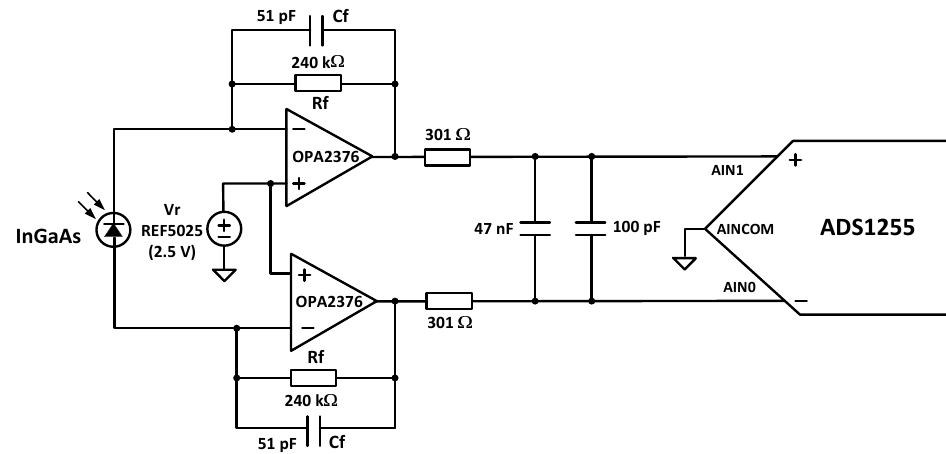
Figure 7. Transimpedance amplifier Figure 8. Transimpedance amplifier circuit.